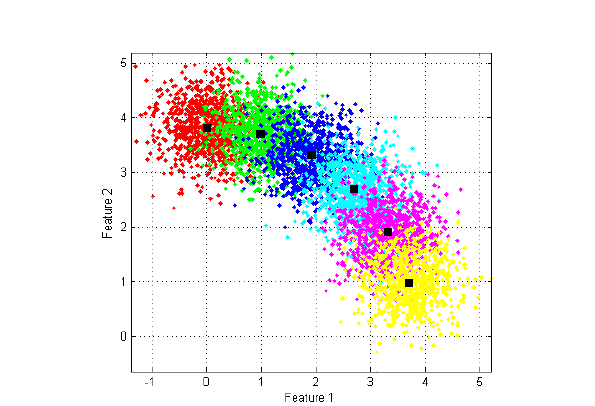
Figure 2: The simulated ordinal data set consists of six Gaussian distributed classes. Each class is represented by a different color, the centroids of the classes are represented by black squares.